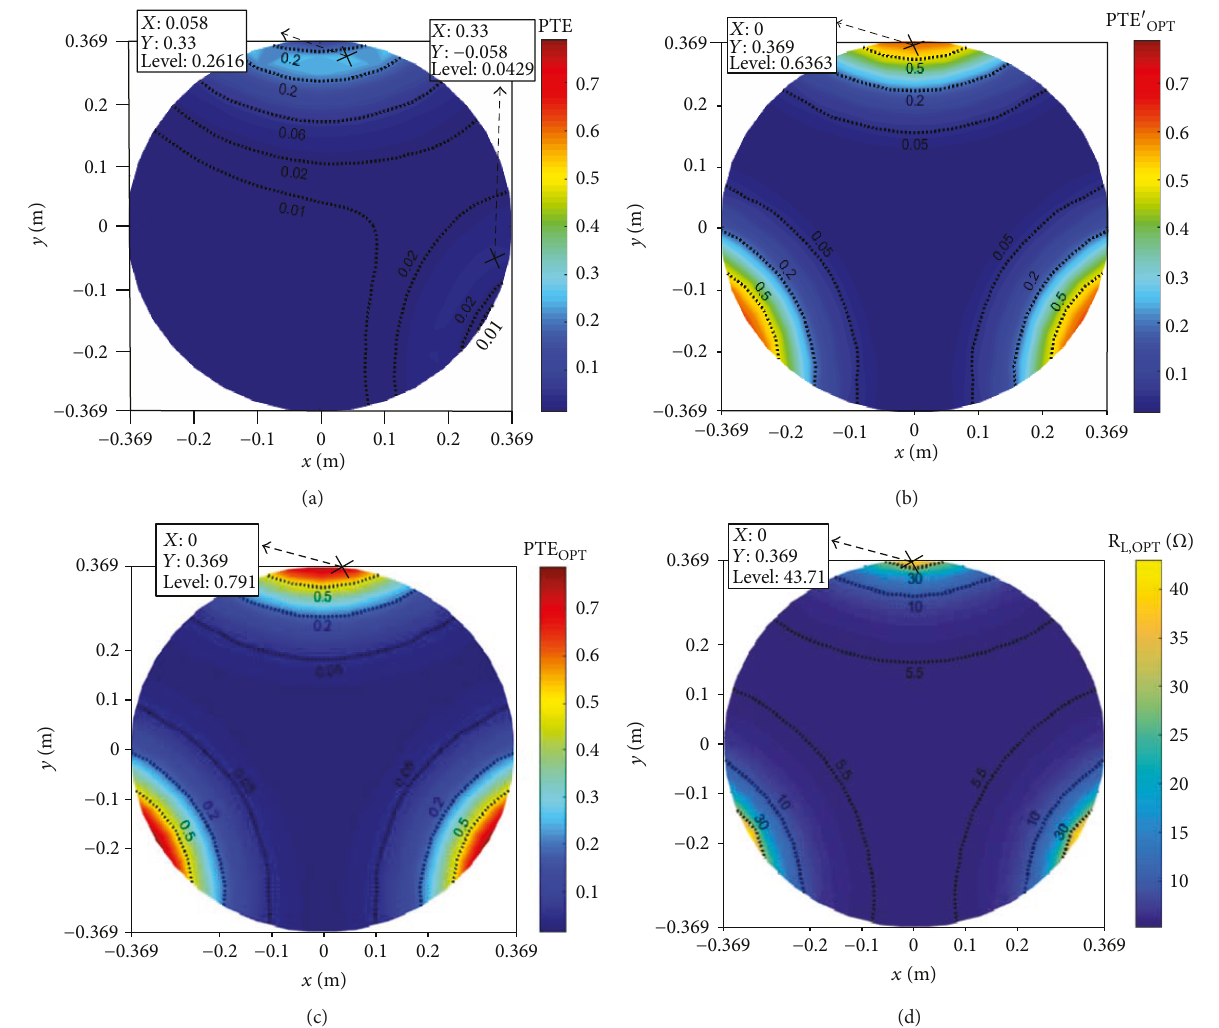
Figure 5: Calculated values of a three-TX system when RX is moving in the study area. E ffi ciency distribution in the study area (a) without optimization, (b) under conditions of V 1 V 2 V 3 = M 1 R M 2 R M 3 R and R L = 10 Ω , and (c) under conditions of